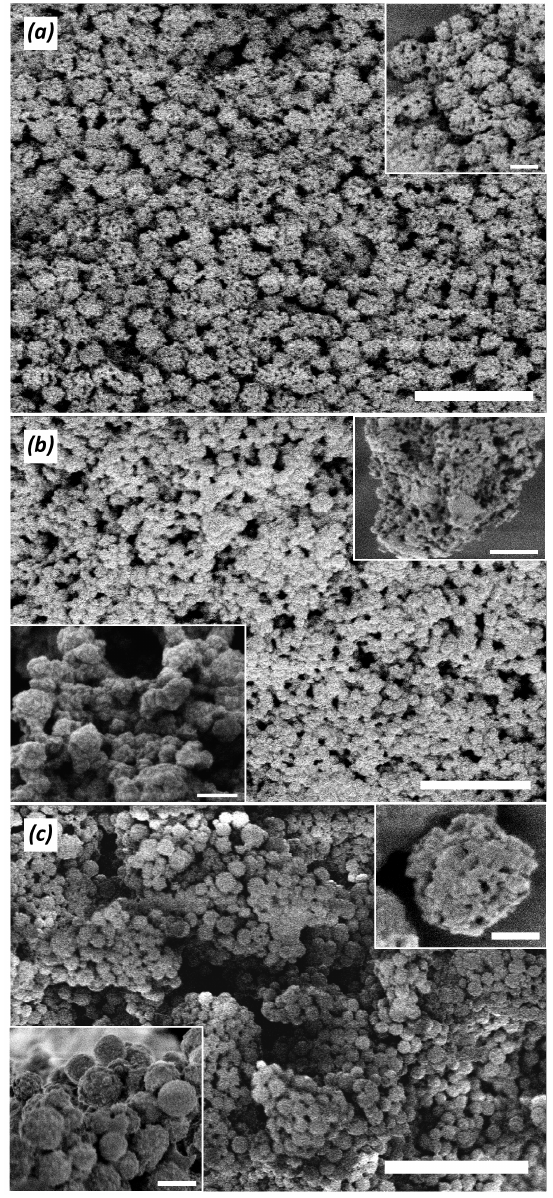
Figure 8. Scanning electron microscopy (SEM) images of composite precipitates obtained under silicic acid condensation in the presence of new copolymers. ( a ) P02; ( b ) P03; and ( c ) P13 copolymers. Initial Si(OH) 4 concentration is 10 mM, polymers = 1.5 g·L − 1 , pH = 7, condensation time = 24 h. Scale bar represents 1 μ m ( a , b ), 200 nm (insertion in ( a ), bottom insertion in ( b ), top insertion in ( c )), 500 nm (top insertion in ( b ) and bottom insertion in ( c ), and 5 μ m ( c )).